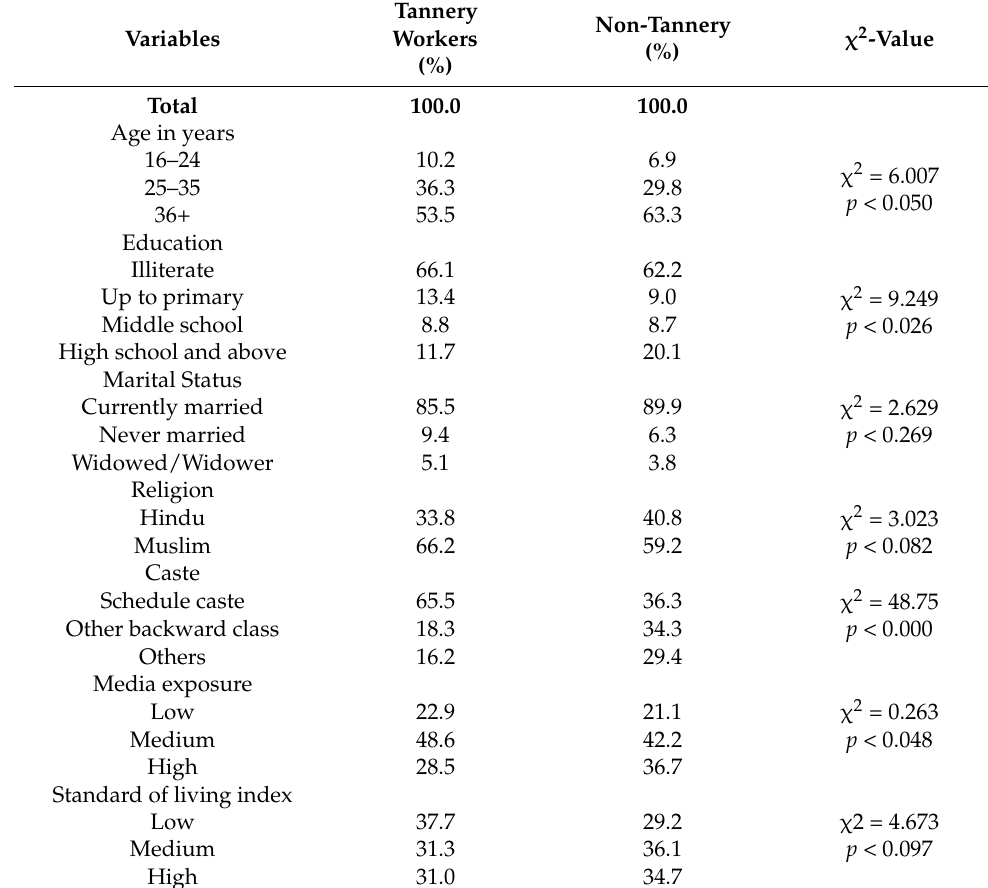
Table 1. Percent distribution of tannery and non-tannery workers by some selected background characteristics in Kanpur, India,